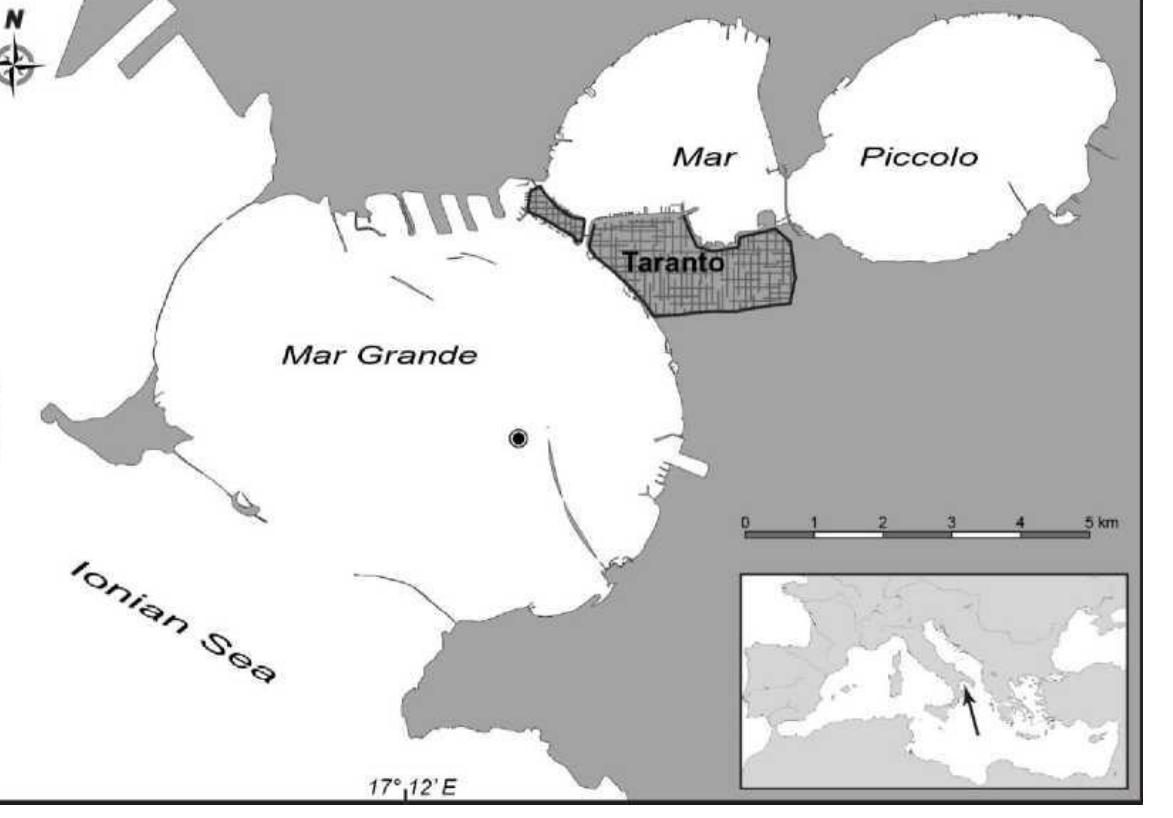
Figure 1. Location of the study sites in the Gulf of Taranto (Ionian Sea, Mediterranean Sea).